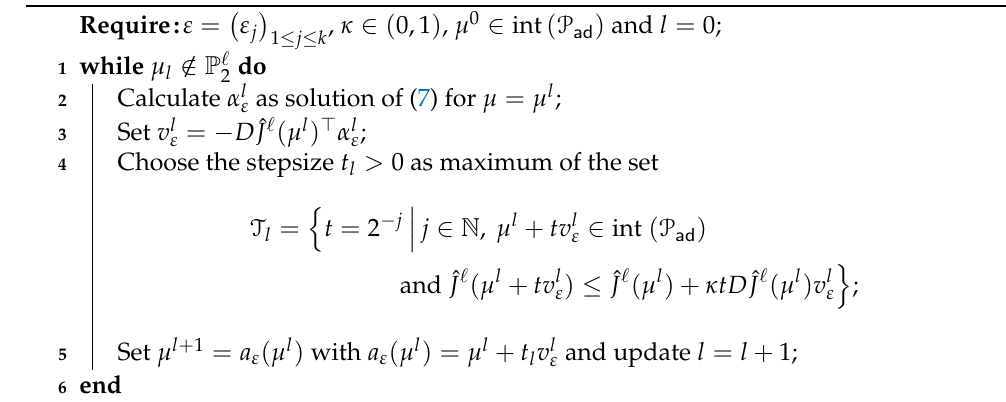
Algorithm 2: Descent method with inexact